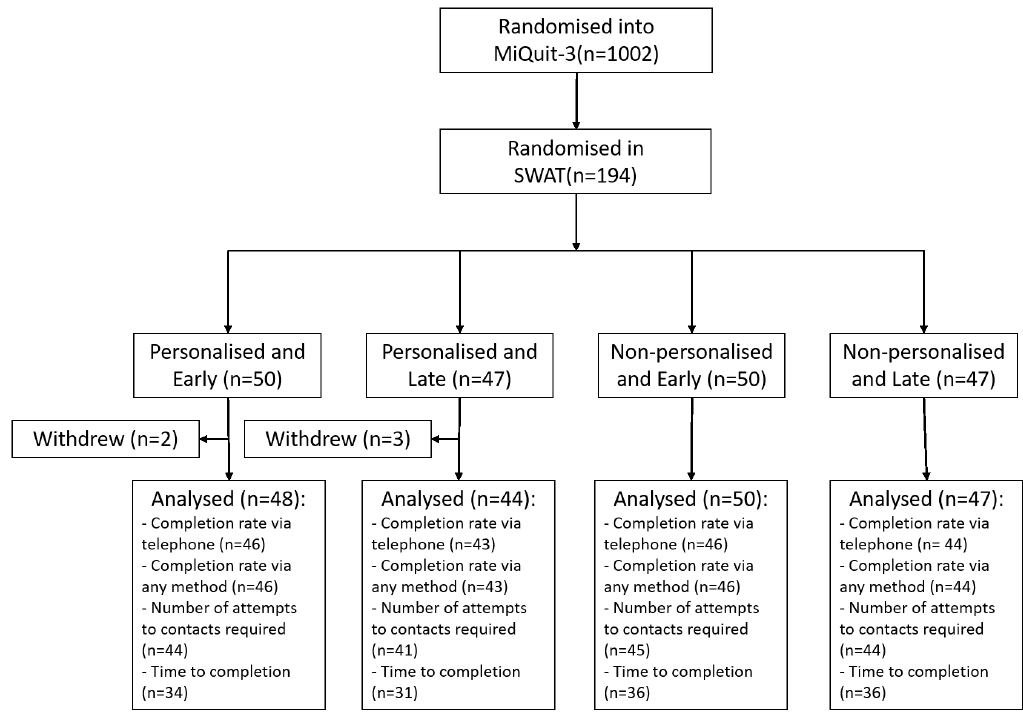
Figure 1. Flow of participants through the SWAT.